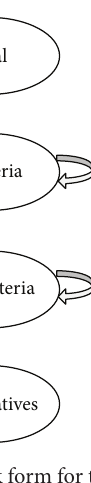
Figure 2: Network form for this